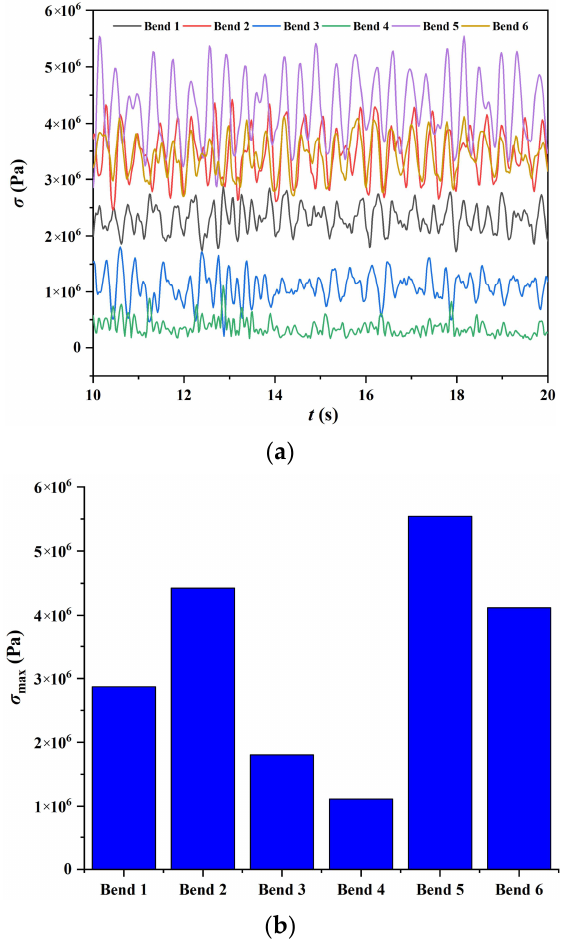
Figure 11. The stresses of monitored bends for the vibrating jumper in case 1, where σ max is the maximum stress, σ is the structural stress, and t is the flow time: ( a ) time series of structural stresses; ( b ) comparison of the maximum stress.